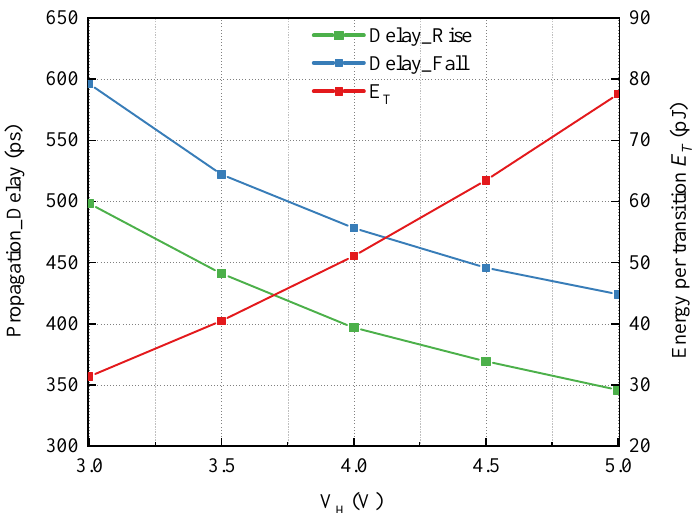
Figure 10. Simulation of the propagation delay and energy per transition ( E T ) versus power supply V H